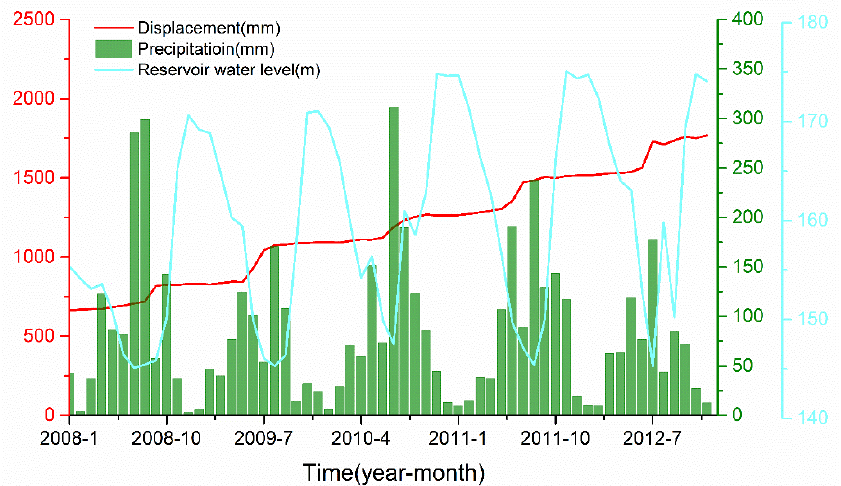
Figure 9. Relationship between the displacement of Bazimen landslide and external environmental factors.